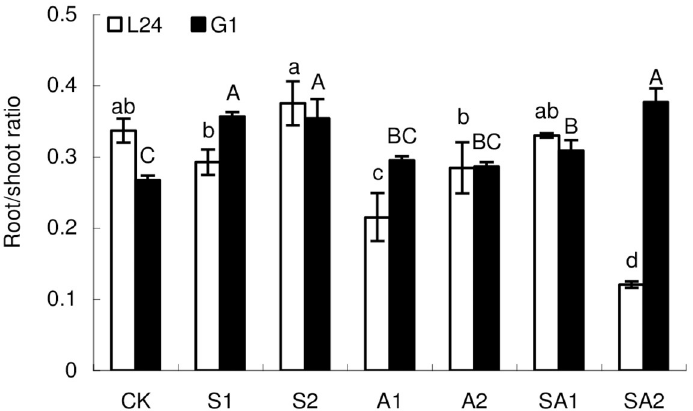
Fig 1. Root/shoot ratio of two cotton varieties under different salt stresses. Symbols indicate L24 cultivar (white bar) and G1 cultivar (black bar). Vertical bars represent ± standard error (n = 6). Bars labeled with the different lowercase letters or uppercase letters are significantly different ( P < 0.05) among different saline and alkaline stress treatments.